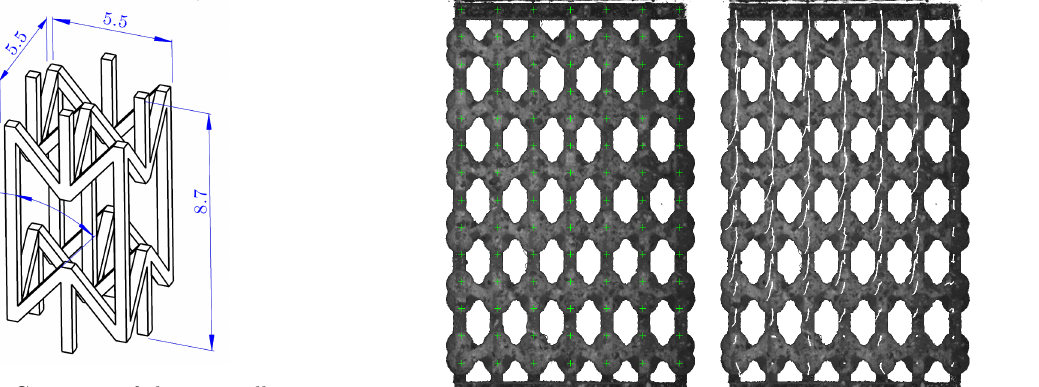
Figure 1. Geometry of the unit cell.